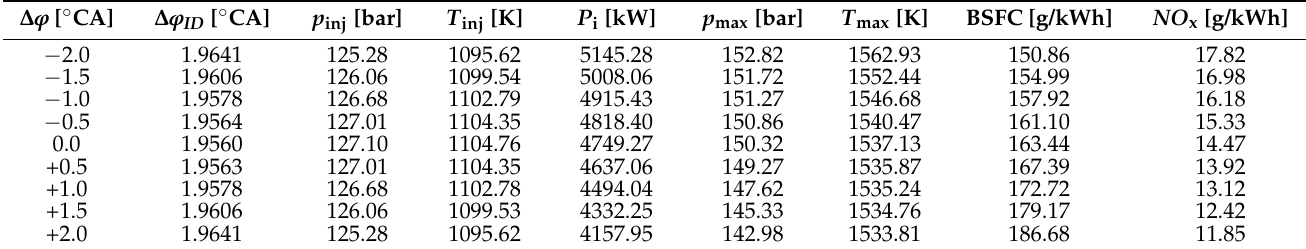
Table 9. Parameters and NO x emission changes due to changes in fuel injection timing at 50% MCR